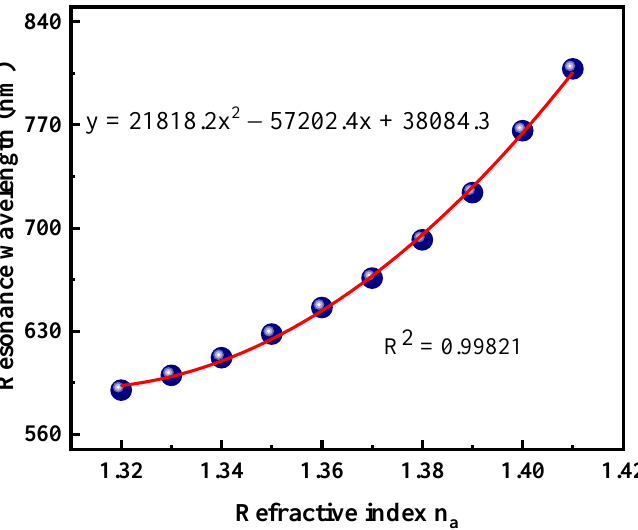
Figure 8. Polynomial fitting curve for sample refractive index (RI) variations from 1.32 to 1.41.